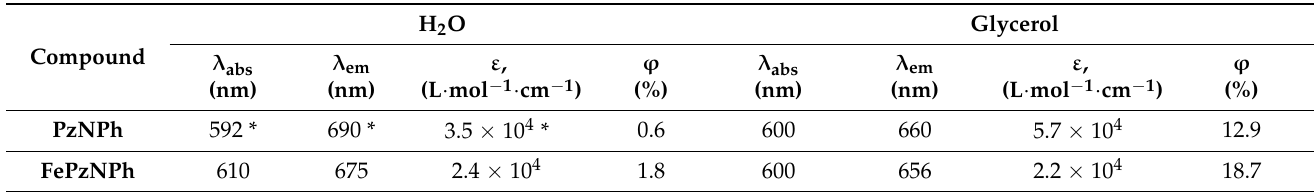
Table 1. Spectral properties and fluorescence quantum yield of PzNPh and FePzNPh